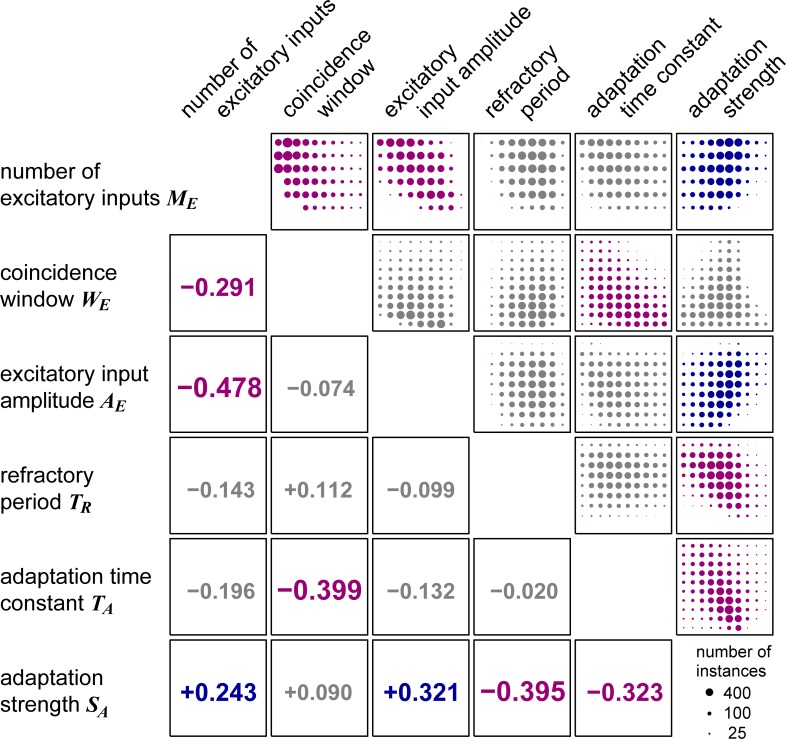
Distribution and correlations of pairs of parameters for accepted PLN- and OnL-type GBC model instances.(Upper triangle) Distribution of parameter pairs. Each square panel presents the distribution of a specific parameter combination. The vertical or horizontal axis of each panel spans the range of a corresponding parameter (Table 1). Ascending parameter values are arranged from down to up (along the vertical axis) or from left to right (along the horizontal axis). The area of each filled circle shows the count of accepted parameter pairs. (Lower triangle) Correlation coefficients of parameter pairs. Distributions and values are marked in blue (positive correlation) or purple (negative correlation) for parameter pairs with an absolute correlation coefficient over 0.2 (and with p < 10−9 for 7520 + 4094 = 11614 instances), and in gray otherwise (i.e., with absolute correlation coefficients below 0.2).